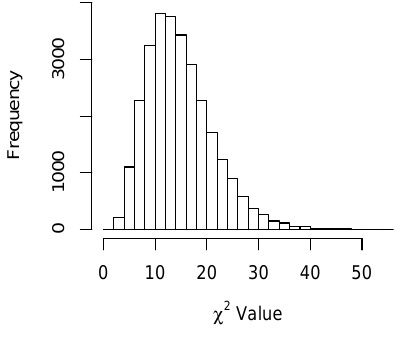
Figure 11. Frequency distribution of the χ 2 values (variance- normalized residual square sum). The distribution has a peak at about 12, tapering to nearly zero at approximately 40. This is a rea- sonable distribution because most pixels contain 15 to 24 observa-